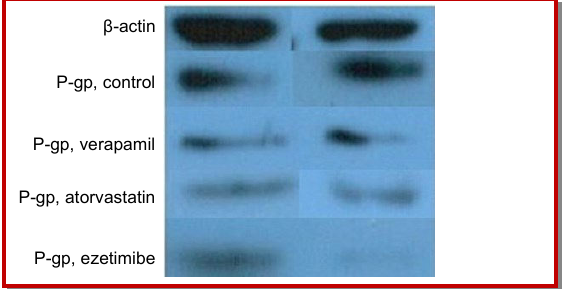
Figure 4: Western blot of P-gp and β - actin in atorvastatin, ezetimibe (100 µM), and verapamil (300 µM) treated and con- trol Caco-2 cells (bands of 2 samples of each are